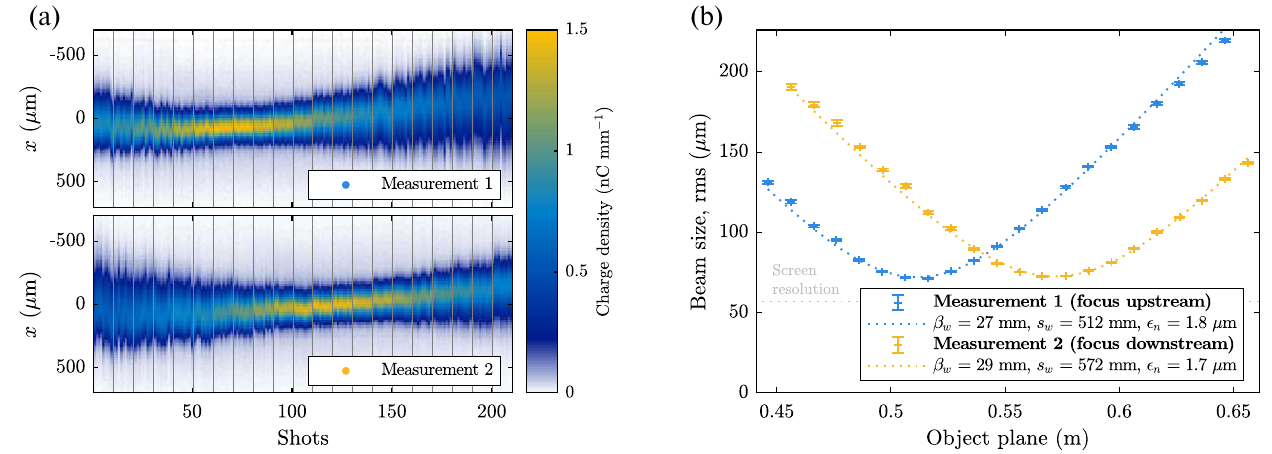
FIG. 5. Quadrupole scans on a downstream spectrometer screen performed during the two-BPM measurements in Fig. 4, (a) imaging the beam from a range of object planes around the beam waist. (b) The variation of horizontally projected beam size for each object plane indicates that the beam was focused to a small waist beta function (27 – 29 mm) close to the center of the focus region — only moderately mismatched from measured jitter. The screen resolution was accounted for in the calculation of beam parameters. Error bars represent the standard error of the mean.